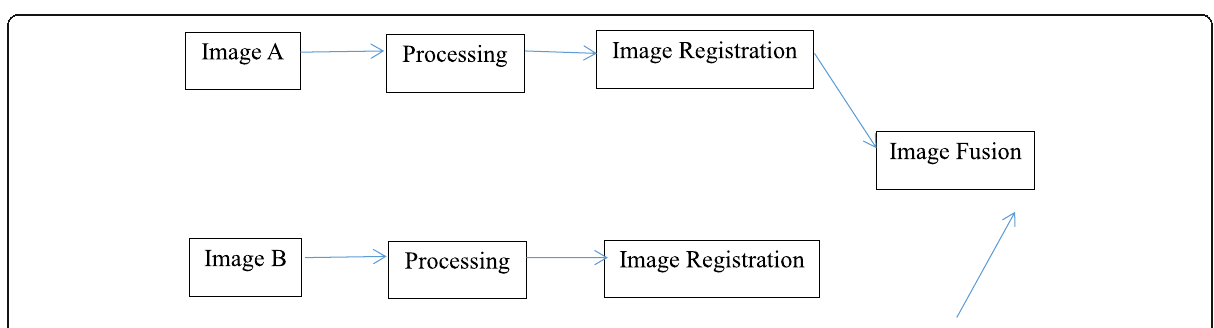
Fig. 1 Schematic of fusion operation flow